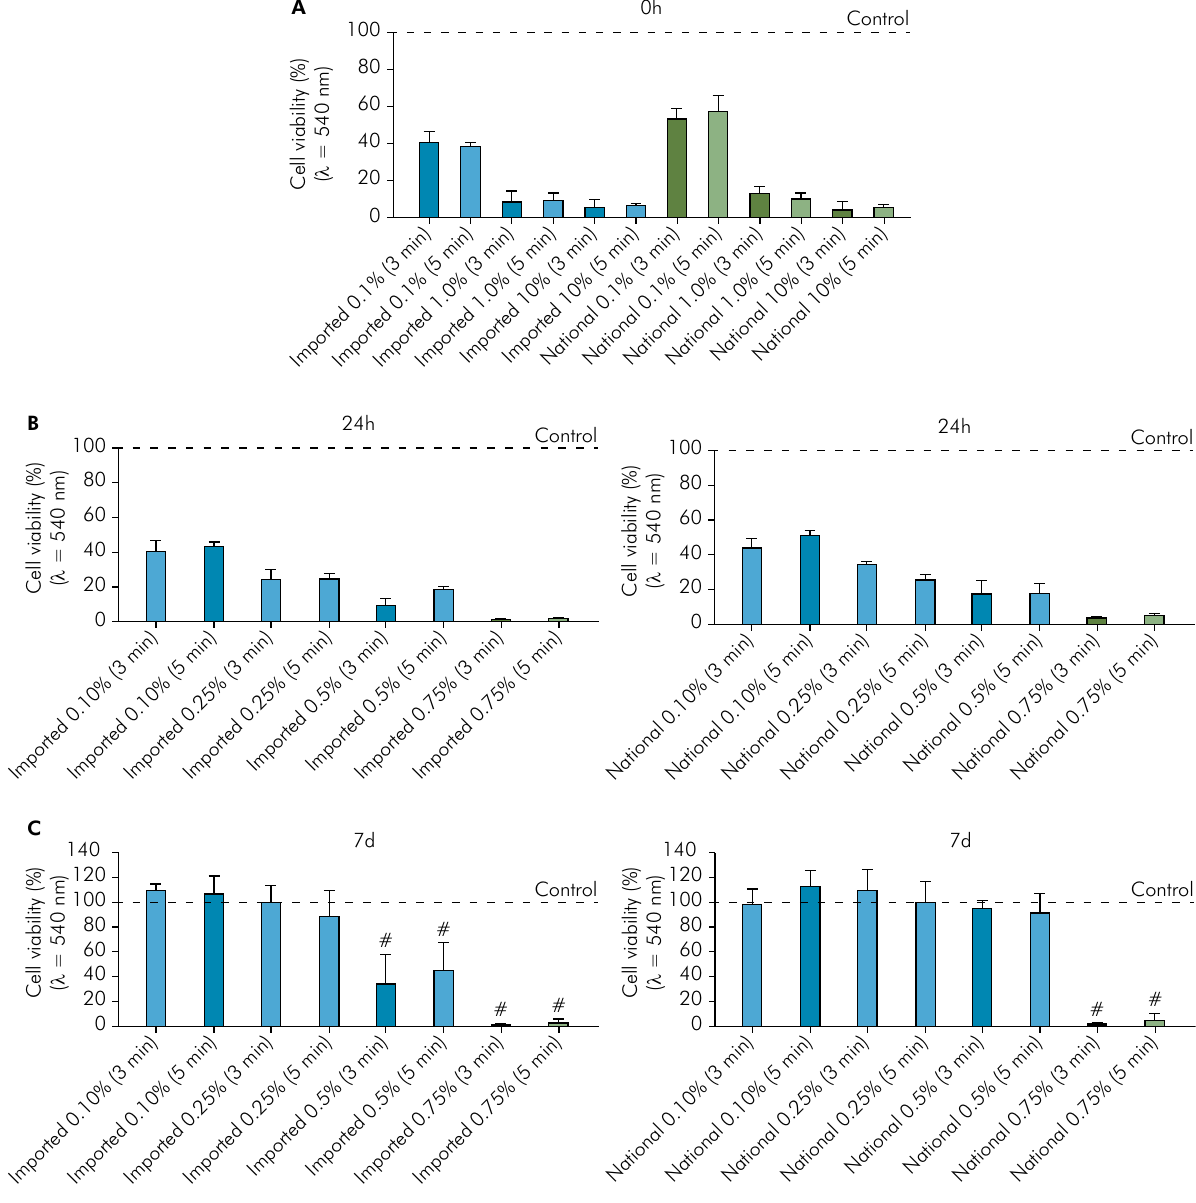
Figure 4. Evaluation of NCSs and ICSs at different concentration s and the following experimental periods: immediately (A), 24 h (B), and 7 days (C). The time of 3 or 5 min was irrelevant for cell growth in most analyses, with the exception of 0.50% for ICS and 0.75% for both ICS and NCS at T2. # indicates statistical difference between the cell viability evaluations after 3 and 5